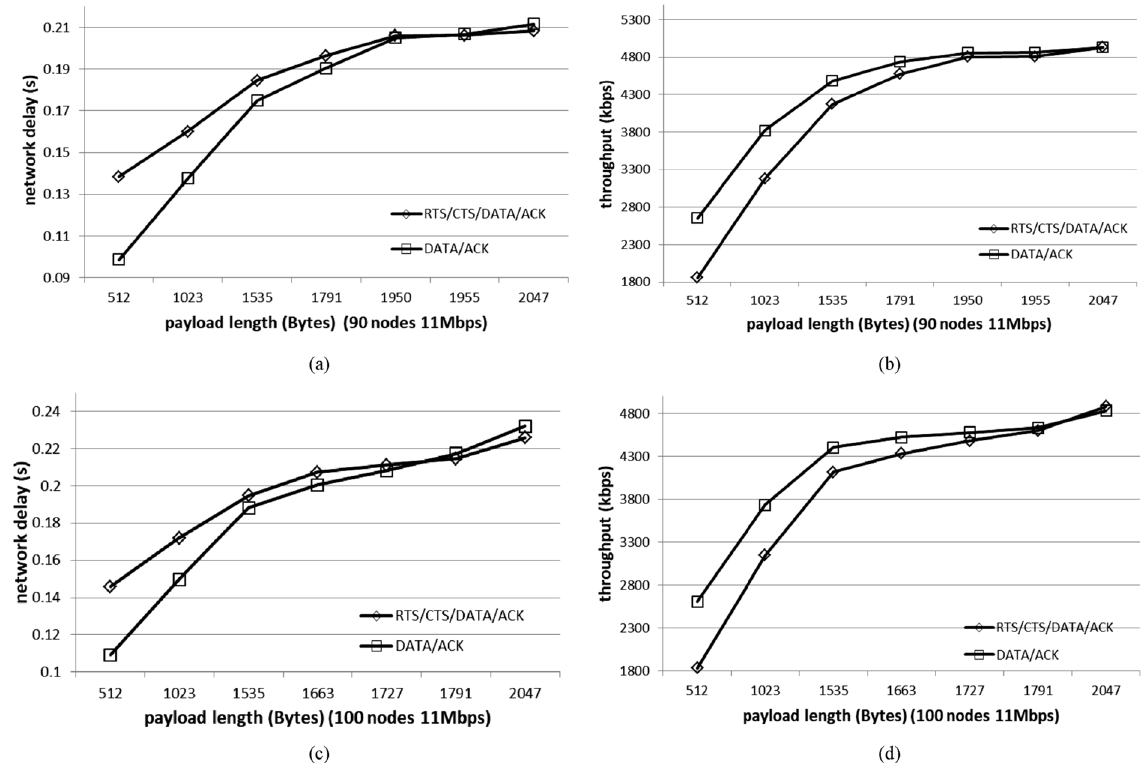
Figure 3. Network performance with DATA/ACK type and RTS/CTS/DATA/ACK type. In a network of 90 nodes, we get payload transmission time h 90 t = 1354 ( µ s ) and payload length L payload ( h 90 t ) = 1862 ( Bytes